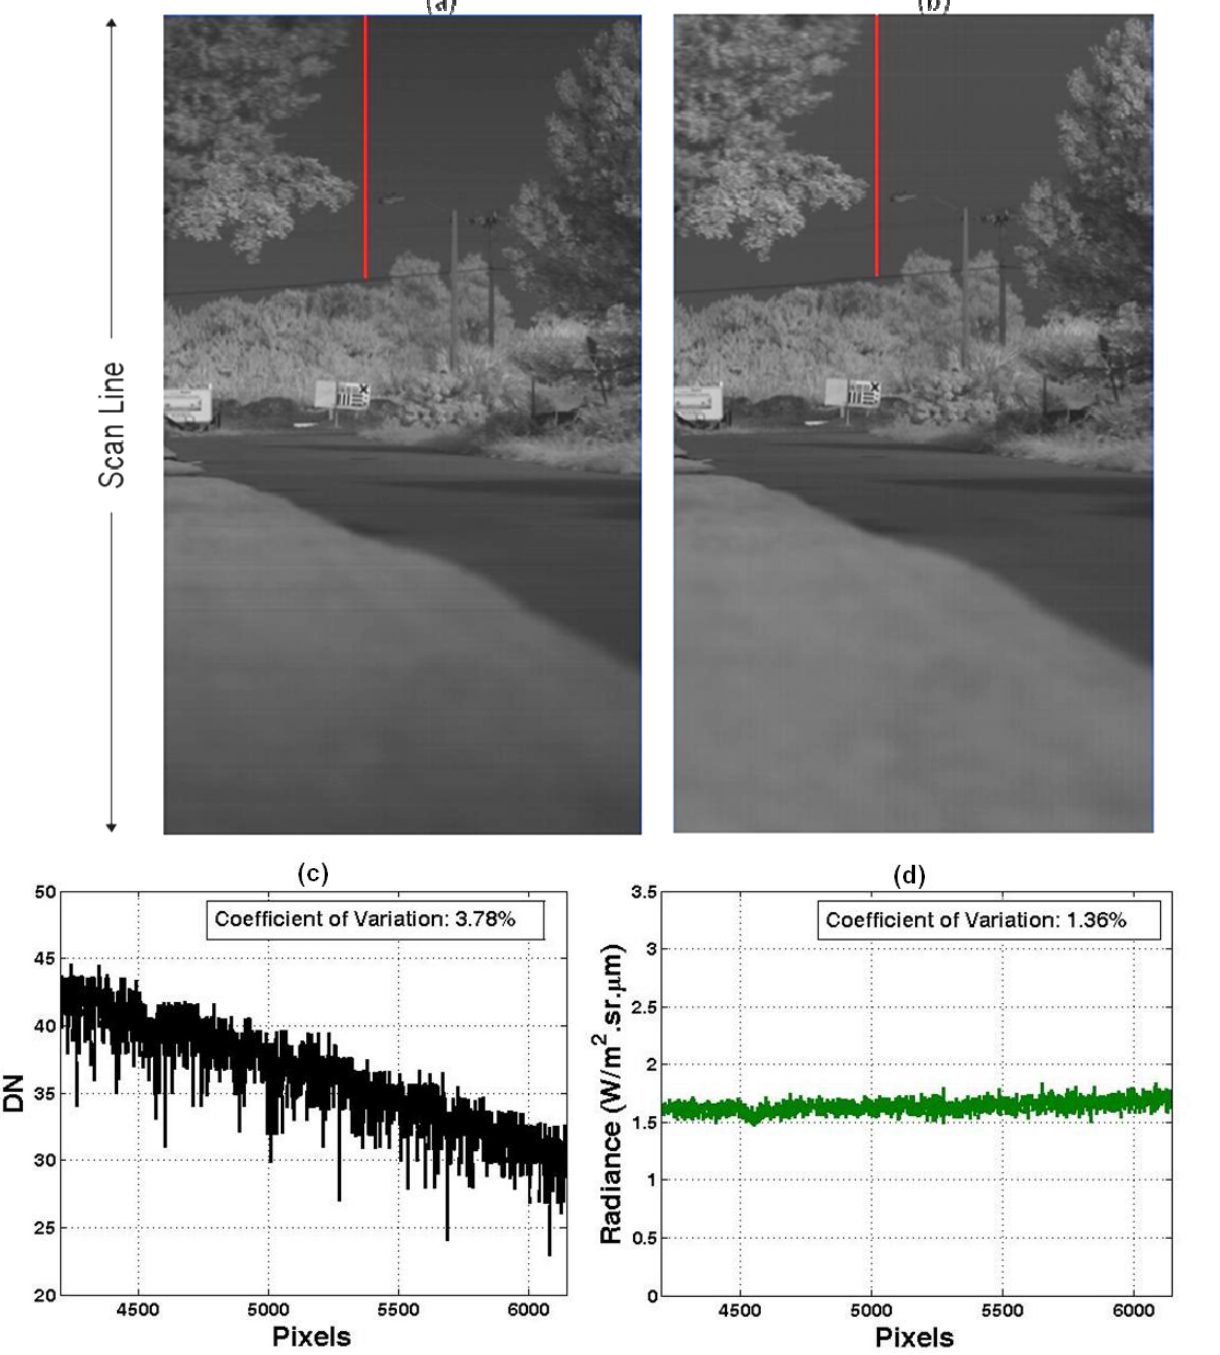
Figure 9. Same as Figure 8 but for AgCam image (NIR, 300  s), acquired August 1st, 2006 at West Palm Beach,